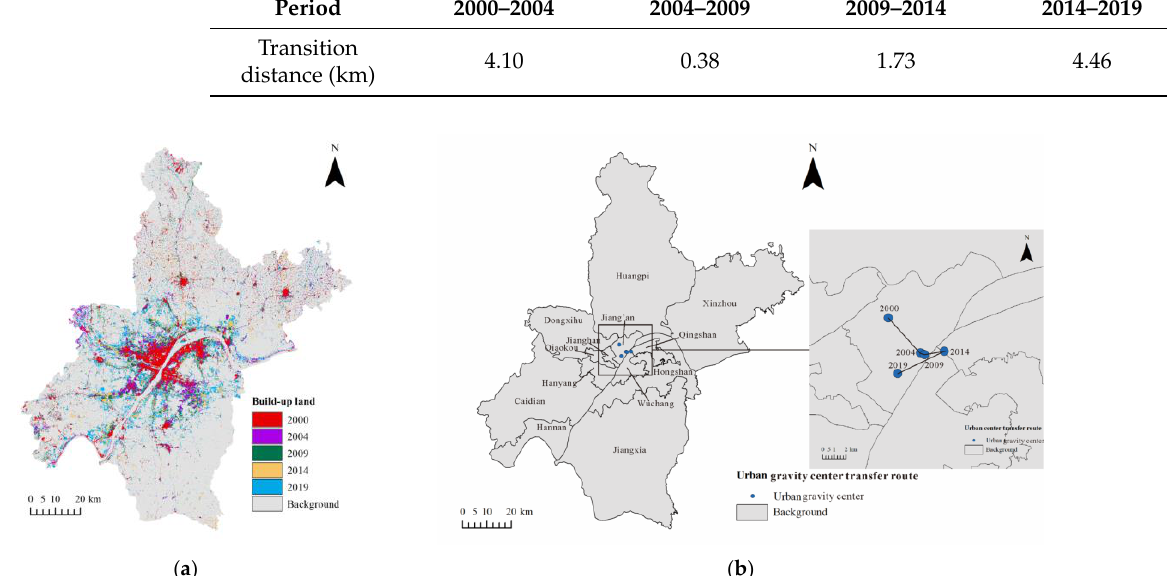
Figure 12. The urban scope and gravity center transition: ( a ) the urban scope of typical years; ( b ) the urban gravity center transfer route.